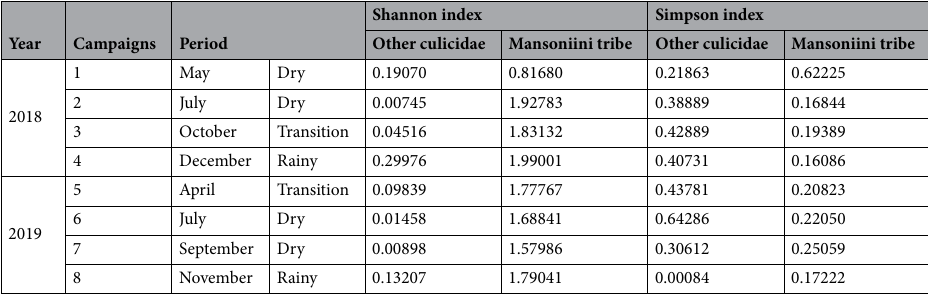
Table 6. Shannon diversity index and Simpson index for adult Culicidae captured in areas near the Jirau hydroelectric plant in Rondônia state, Brazil, in 2018 and